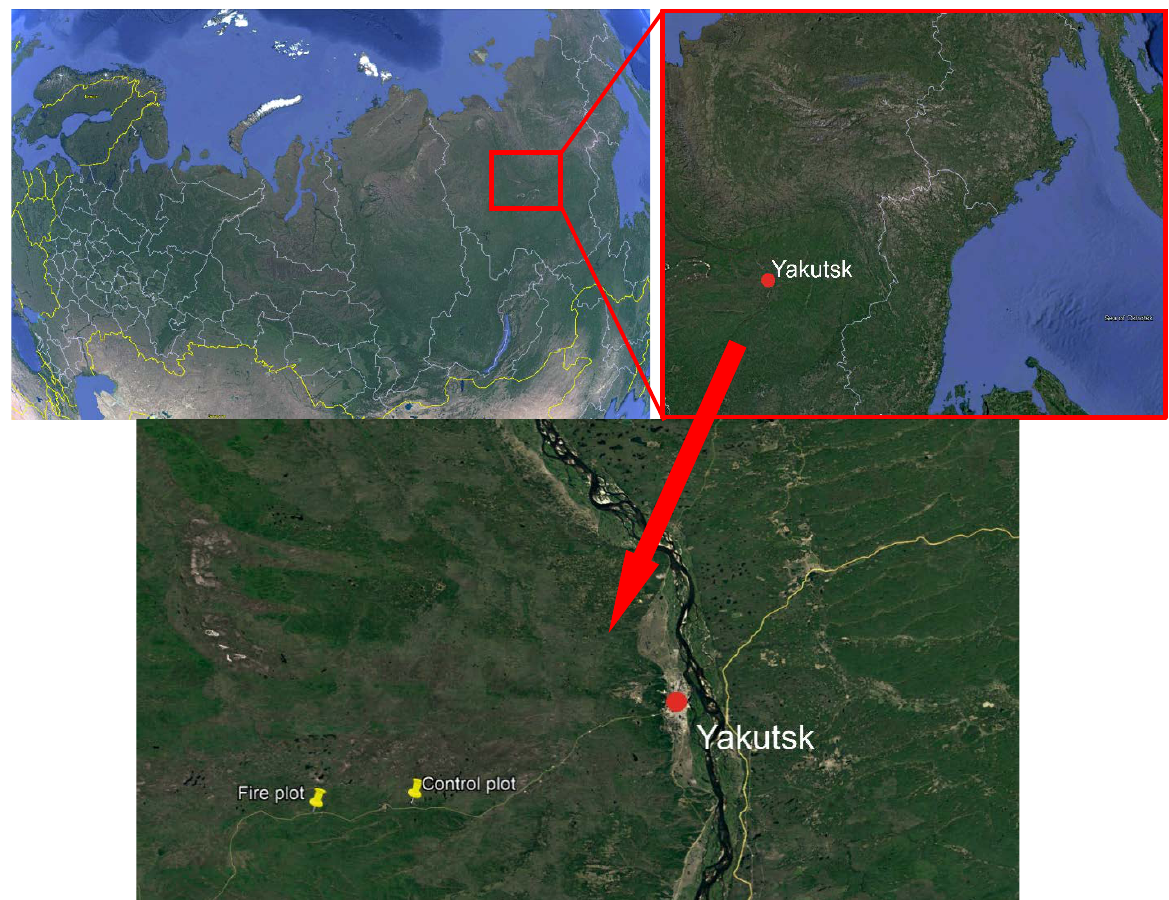
Figure 1. The study site location. The source of this map is Google Earth Pro (https://www.google.com/intl/ru/earth/ (accessed on 10 November 2022)).